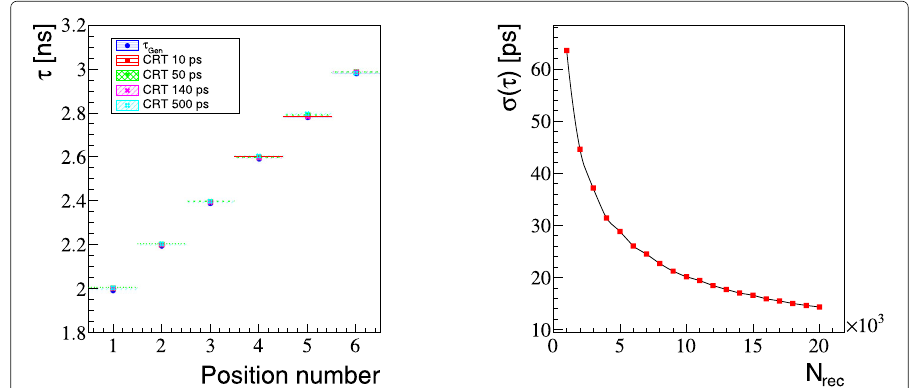
Fig. 7 Left: Comparison between generated positronium mean lifetime and reconstructed one assuming different detector CRT resolutions as a function of NEMA position number (see Table 1). Differences between obtained results are in the order of O (10 ps). Right: Resolution of the mean lifetime determination as a function of detected entries in a single